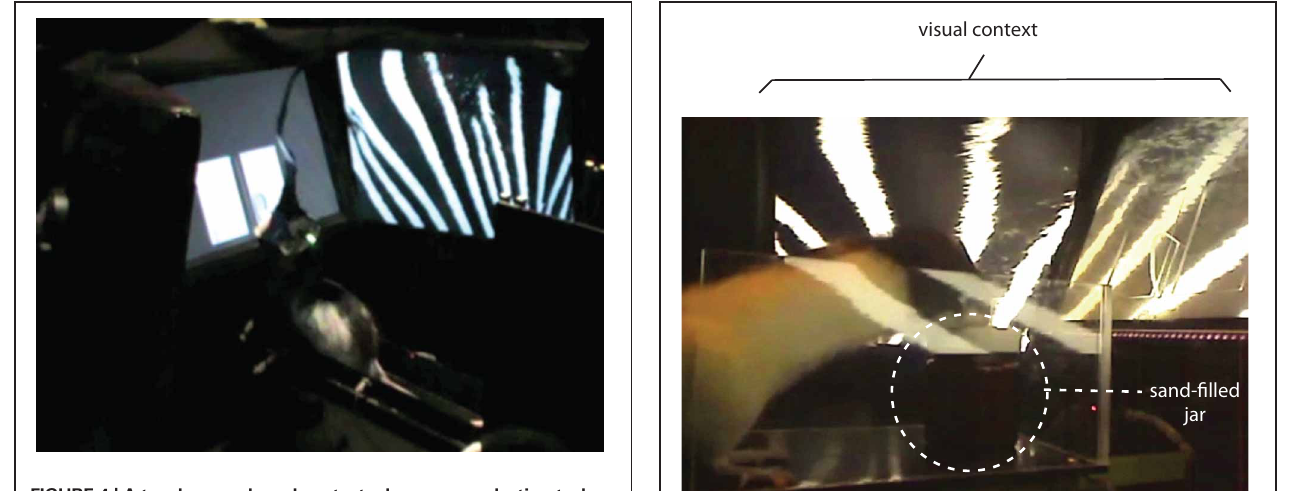
FIGURE 4 | A touchscreen-based contextual response-selection task. A side view of the LCD-touchscreen apparatus in which two peripheral LCD screens (only one visible from this particular angle) and the center touchscreen (showing two adjacent response target rectangles) were installed to make the rat to choose a particular response using the surrounding visual context (zebra pattern in this example). The LEDs and tether attached to the rat are for electrophysiological recording.